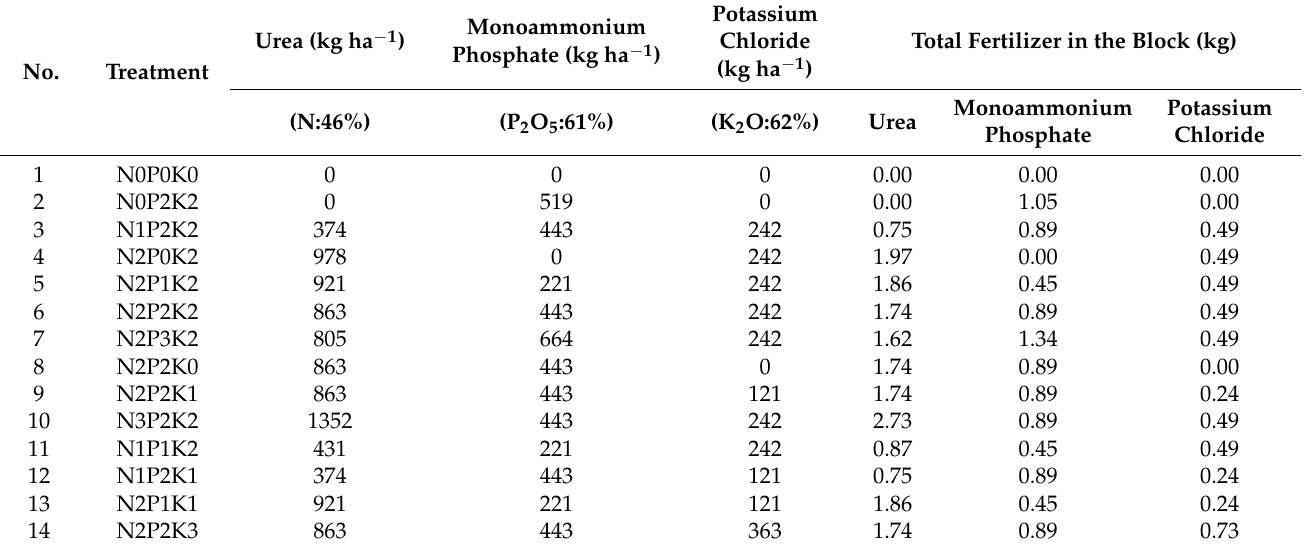
Table 1. The 3414-fertilization experiment design for